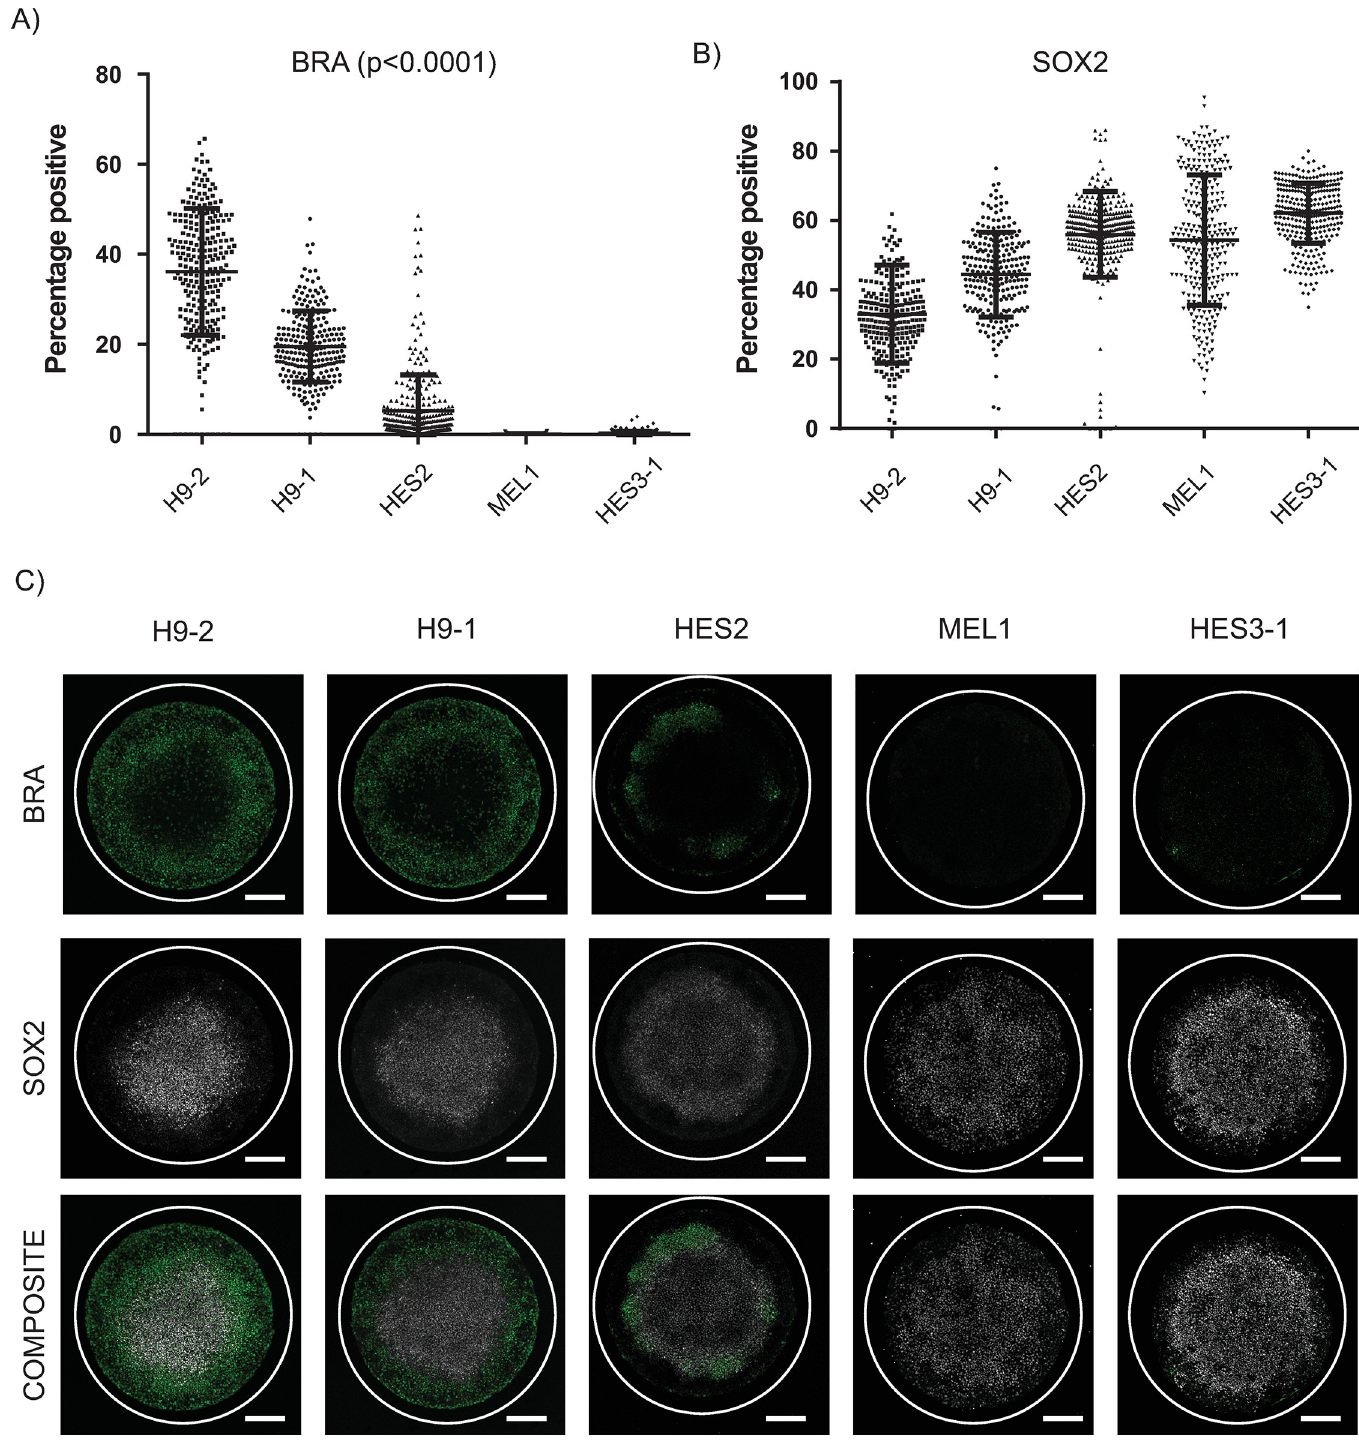
Fig 2. Variability in peri-gastrulation–like induction observed between test hPSC lines. (A–B) Quantified expression of BRA (A) and SOX2 (B) observed within the assayed hPSC lines tested. Number of colonies were 252, 245, 327, 288, and 304 for H9-2, H9-1, HES2, MEL1, and HES3-1, respectively. Each data point represents individual colonies identified. Data pooled from 2 experiments. (C) Representative immunofluorescent images for BRA and SOX2 for the test hPSC lines. Scale bar represents 200 μ m. For DAPI staining, please see S3B Fig. Underlying numerical data for this figure can be found in https://osf.io/zrvxj/. BRA, Brachyury; hPSC, human pluripotent stem cell; SOX2, SRY (sex determining region Y)-box 2.